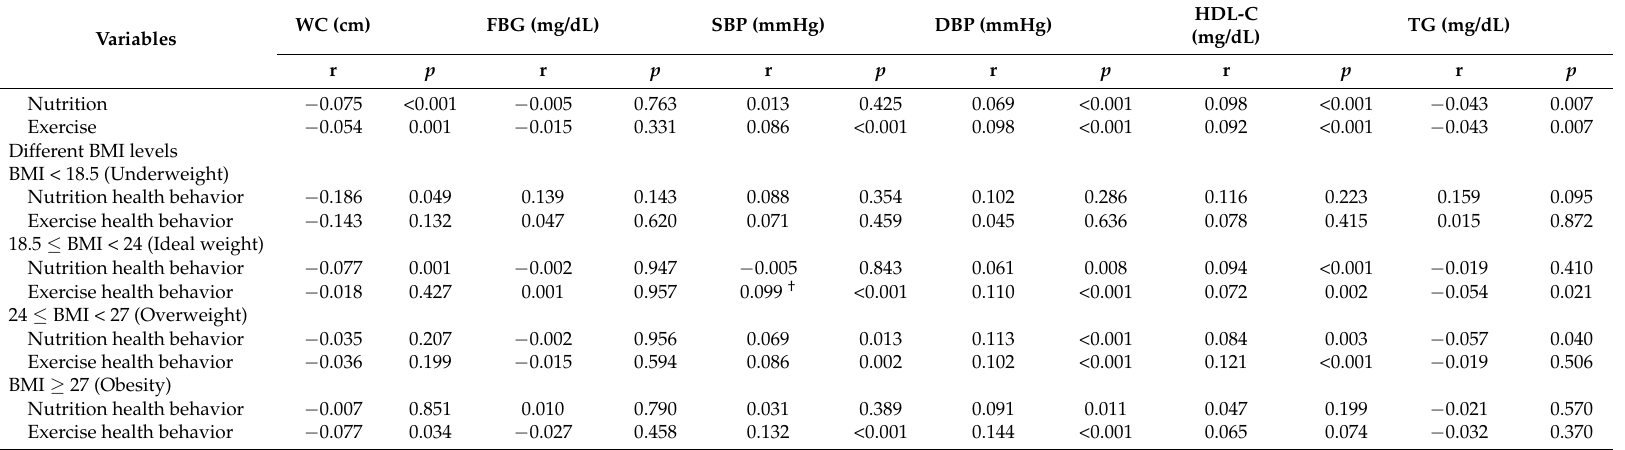
Table 3. Crude correlations of metabolic risk factors and nutrition and exercise health behavior †